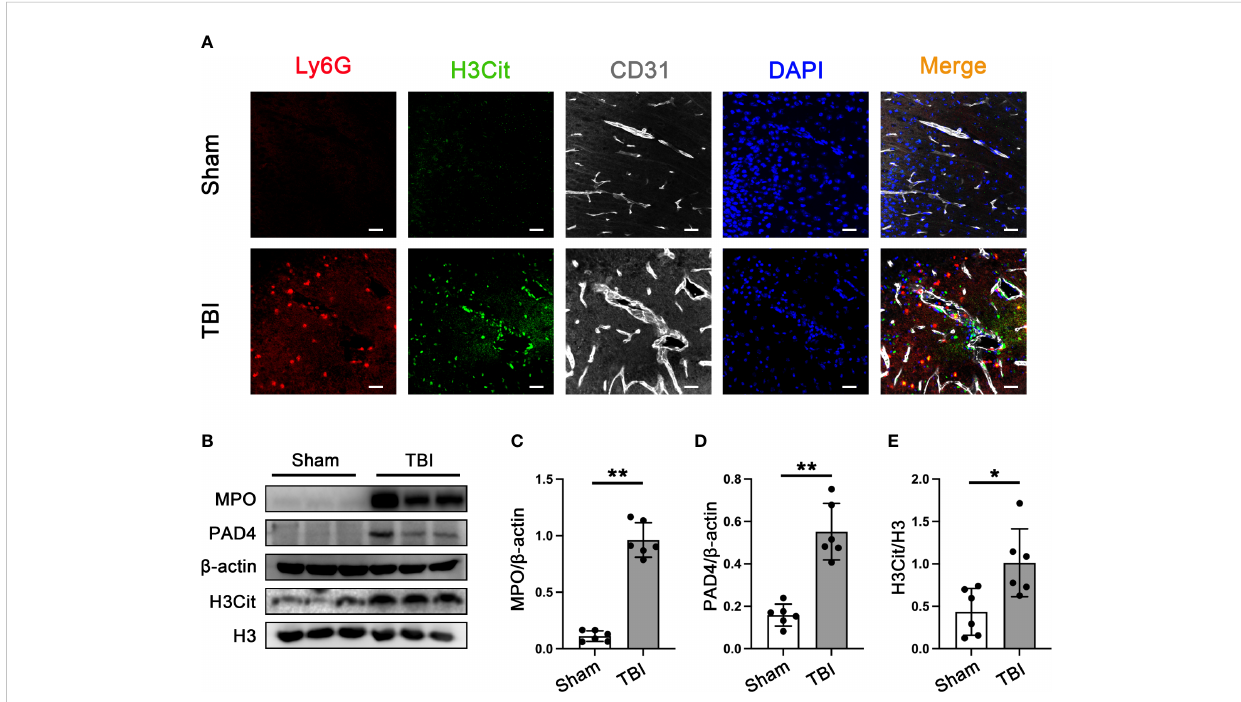
FIGURE 2 Neutrophils in fi ltration and NETs formation in mice brain tissue. (A) Representative immuno fl uorescence staining of Ly6G-positive neutrophils (red) and H3cit -positive(green) and CD31-labeled blood vessels (white) in the mice brain tissue sections post-CCT 3 days. Nuclei were stained with DAPI (blue). (B) Representative Western blot bands of MPO, PAD4, H3Cit, and H3 and statistical analysis expression level of MPO (C) , PAD4 (D) , and H3Cit (E) in mice brain tissue (n=6). Data are represented as mean ± SD. *P < 0.05, **P <